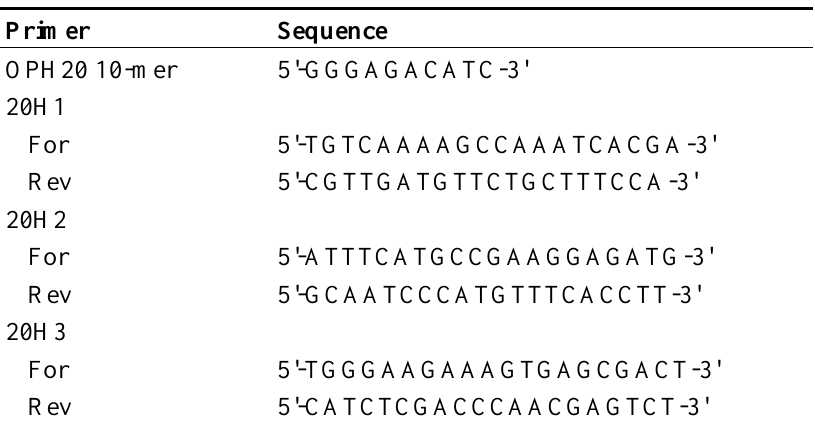
Table 2. Primers used for PCR